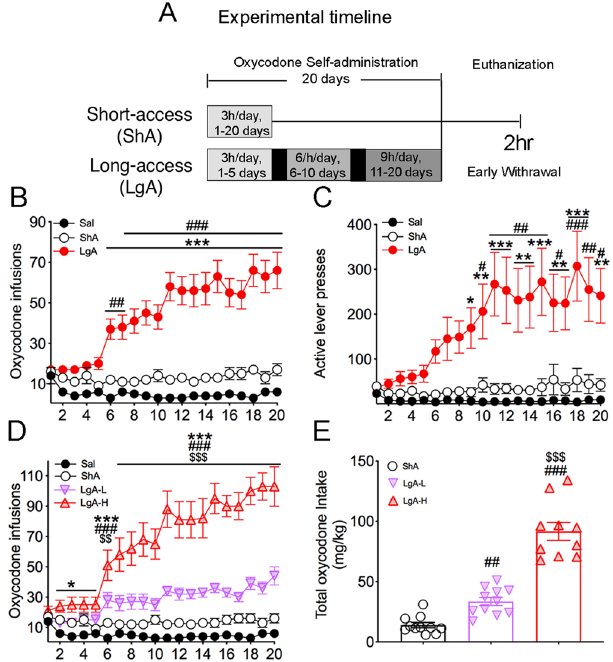
Figure 1. Rats exposed to long-access, but not short-access, oxycodone SA escalate their drug intake. ( A ) Experimental timeline of oxycodone self-administration (SA) training. Rats self-administered oxycodone using either short-access (ShA) (n = 10) (trained for 3 h for 20 days) or long-access (LgA) (n = 21–23) (trained for 3 h for 1–5 days, 6 h for 6–10 days, then 9 h for 11–20 days) paradigms. ( B ) LgA rats escalate their intake of oxycodone after the first 5 days of SA training. ( C ) LgA rats show significant increases in active lever presses during SA training. ( D ) LgA-H rats show two distinct intake phenotypes, high (LgA-H) (n = 10) and low (LgA- L) (n = 13) oxycodone takers, during the escalation phase. ( E ) LgA-H rats took substantially more oxycodone than LgA-L and ShA rats. Key to statistics: *, **, *** = p < 0.05, 0.01, 0.001, respectively, in comparison to Sal rats; #, ##, ### = p < 0.05, 0.01, 0.001, respectively, in comparison to SHA rats; $$, $$$ = p < 0.01, 0.001 in comparison to LgA-L rats. Stats were performed by either one-way or two-way ANOVA followed by Bonferroni or Fisher’s PLSD post hoc